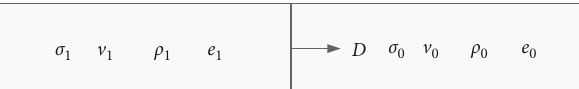
Figure 12: Parameters before and after the intermittent surface.